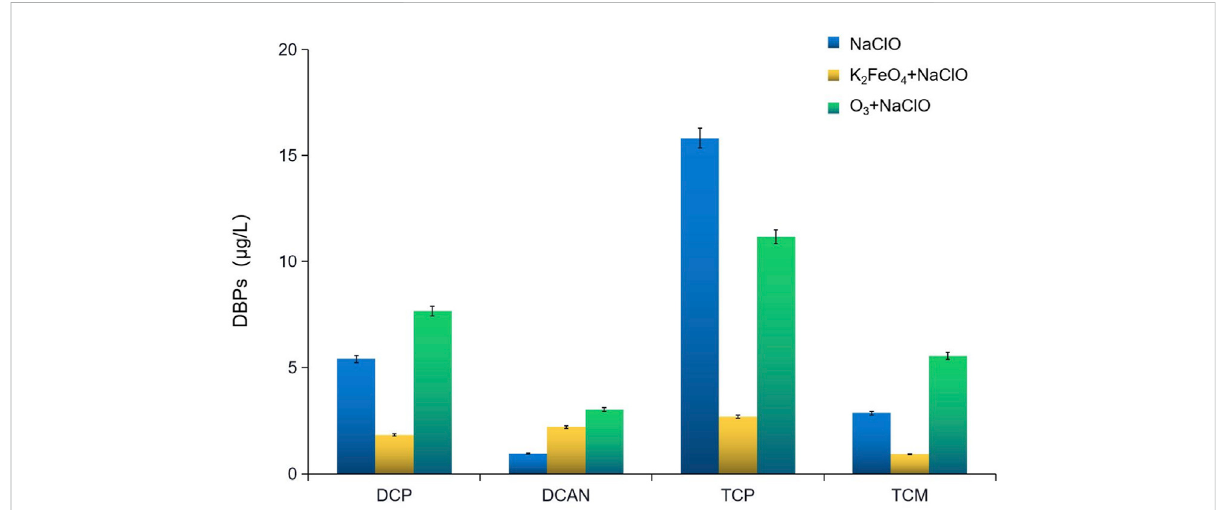
In fl uence of preoxidation by K 2 FeO 4 and O 3 on the change of DBPs formed in SMZ chlorination.